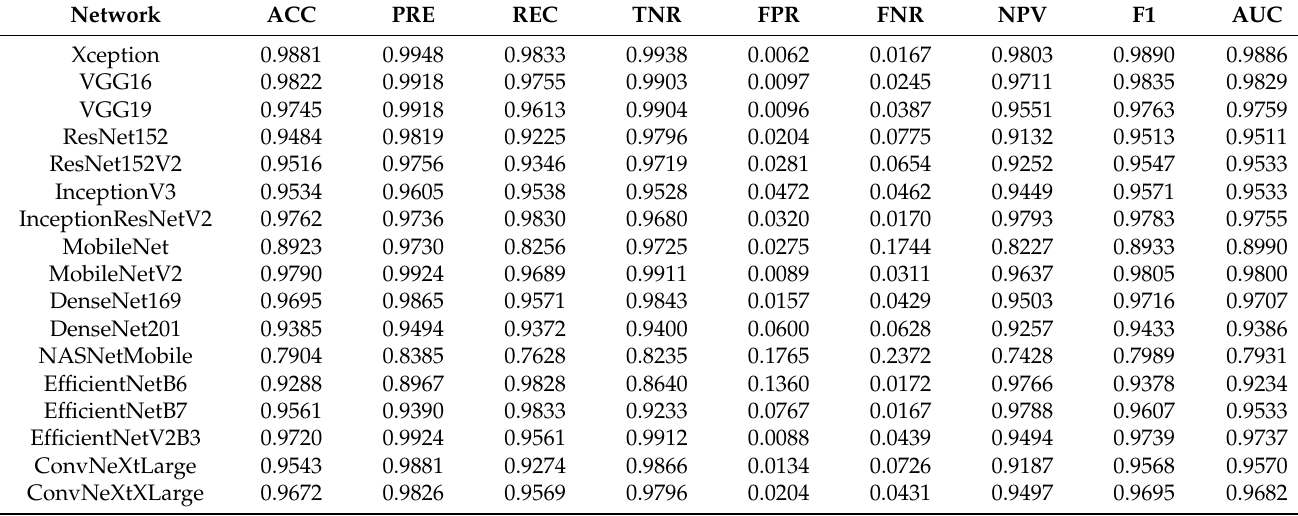
Table 4. Performance